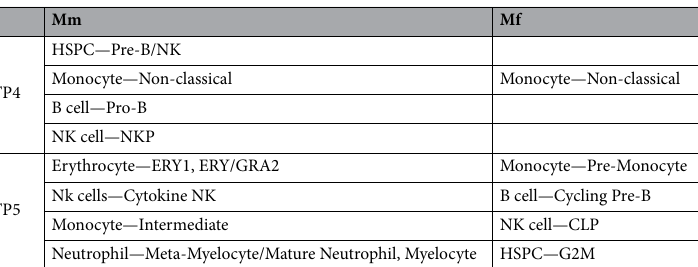
Table 1. Gene markers indicate enriched cell populations (and sub-populations) in the two species at different TPs during the infection. HSPC: hematopoietic stem and progenitor cell; NK cells: natural killer cells; CLP: common lymphoid